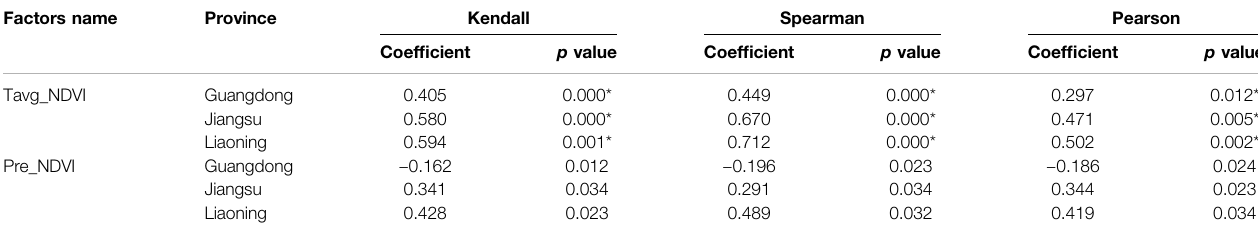
TABLE 2 | The Kendall, Spearman, and Pearson correlation between the mean temperature (Tavg), precipitation (Pre), and its corresponding normalized difference vegetation index (NDVI) during the growing season (April – October) in Guangdong, Jiangsu, and Liaoning provinces. Factors